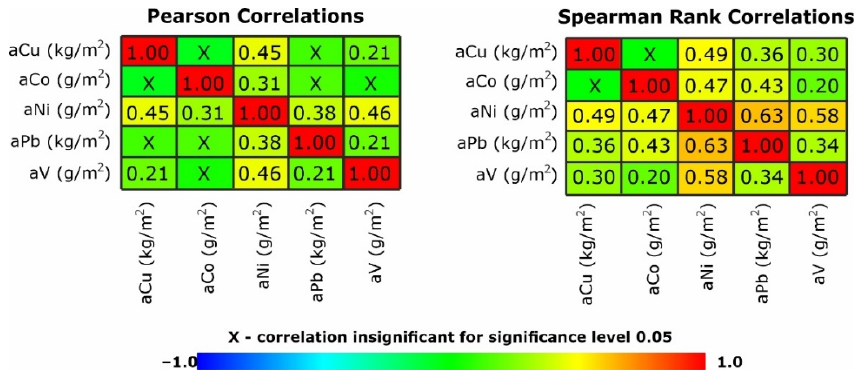
Figure 6. Pearson correlations and Spearman rank correlations between Cu abundance (aCu) and abundance of accompanying elements (aCo, aNi, aPb, and aV) in the Cu-Ag Rudna deposit.